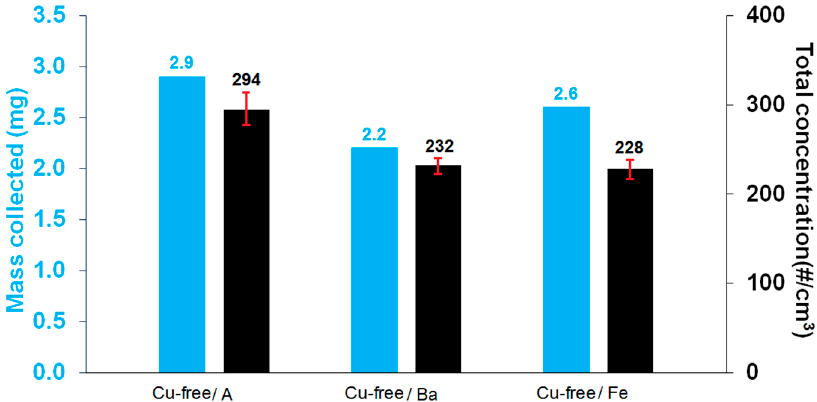
Figure 4. Mass of particles collected and average of number concentration of airborne particles at steady-state for the three tested materials.